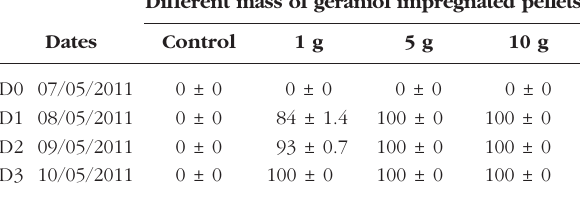
Table III bis. – Experiment B: larval reduction rates (%) of Ae. albopictus in presence of geraniol impregnated pellets, one month after previous test.